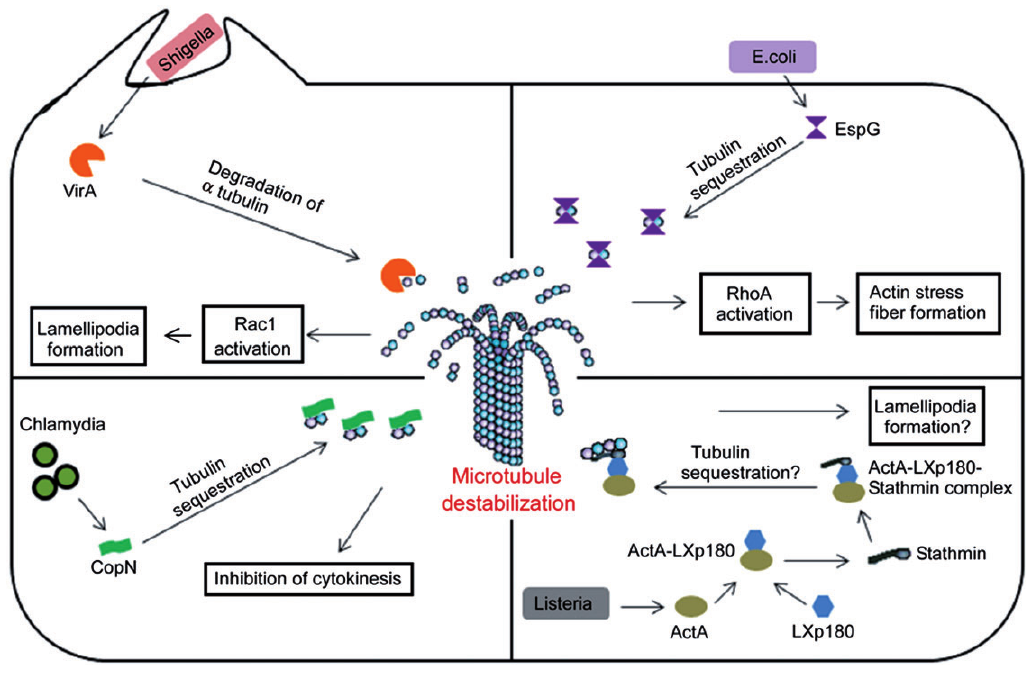
Figure 1 Bacterial effector proteins that destabilize host microtubules. The mechanism of action of effector proteins that has been demon- strated or hypothesized is illustrated. The possible benefi ts of host microtubule destruction for the pathogen have also been depicted in the fi